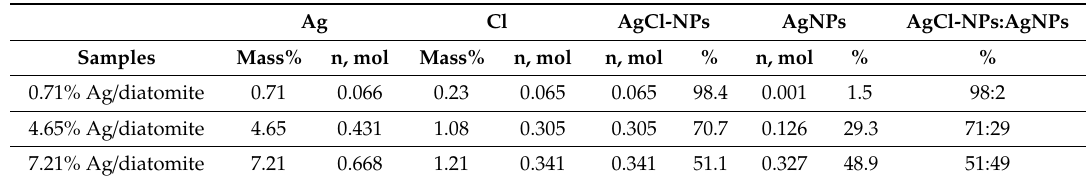
Figure 3. SEM-EDX spectra of the studied diatomite samples: ( A ) raw diatomite, ( B – D ) diatomite with immobilized silver (0.71, 4.65 and 7.21%, respectively). Table 2. Mass fraction and number of moles of silver, chlorine, silver chloride nanoparticles and metallic silver nanoparticles in the obtained composites.